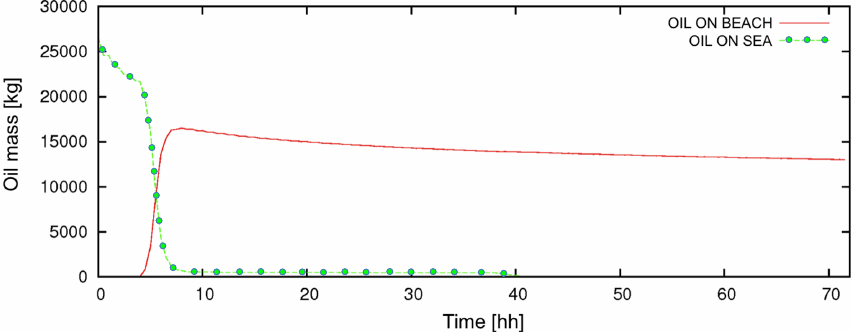
Fig. 9. Temporal variation of the total amount of oil quantity dispersed in the water column (green close symbols curve) and beached on the shore (red